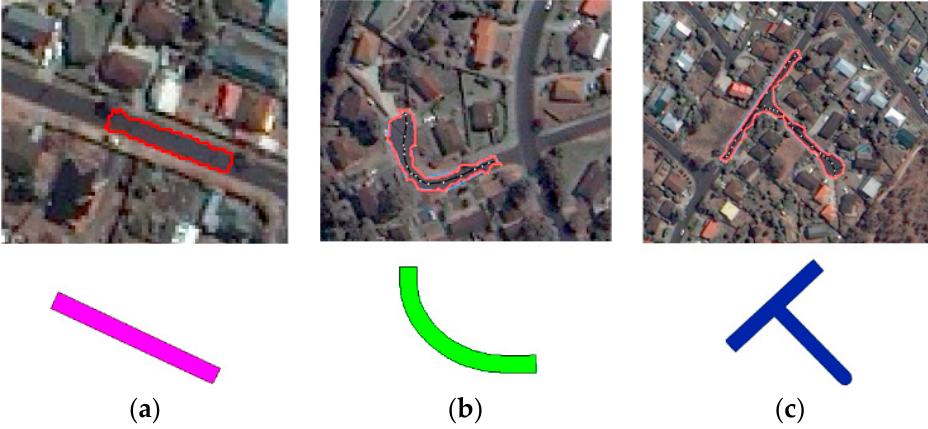
Figure 3. Three types of linear objects with different levels of complexity, which demonstrate the superiority of SOLI: ( a ) rectangular object; ( b ) curved object; ( c ) branched object.